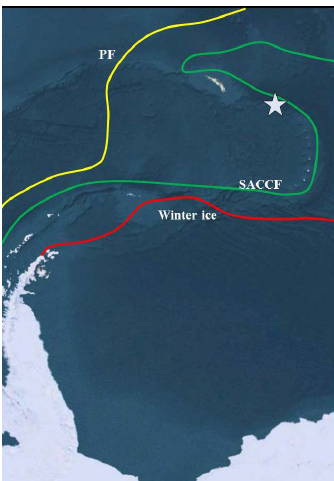
Figure 1. Sampling location. The star shows the approximate location of the sampling point in relation to the Southern Antarctic Circumpolar Front (SACCF, in green), the Polar Front (PF, in yellow) and the maximum winter sea ice recorded in 2011 (Winter ice, in red). Antarctic winter sea ice data for 2011 from the Weddell Sea were obtained from climate.gov. The approximate locations of the Polar Front and the Southern Antarctic Circumpolar Front are a reproduction from Talley et al. , (eds.) Descriptive physical oceanography: An Introduction. Elsevier, 2011 [37]. The background map is derived from Google Earth.